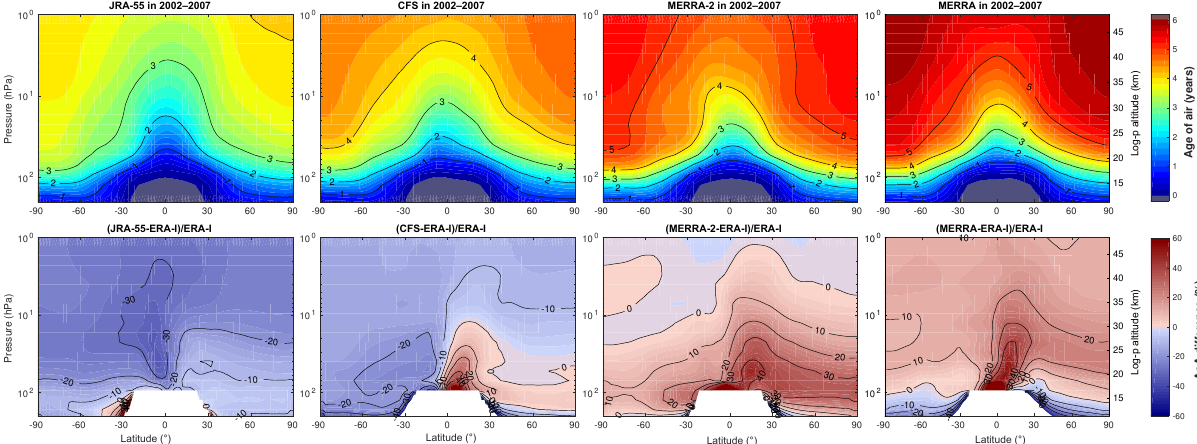
Figure 3. Latitude–pressure distribution of AoA (years) in 2002–2007 from BASCOE simulations driven by all reanalyses but ERA-I (top row; same color scale as previous figure) and relative difference with respect to the mean AoA by the ERA-I-driven simulation for the same period (bottom row; difference is not plotted at grid points where ERA-I AoA is smaller than 5 days). These reanalyses are, from left to right, JRA-55, CFSR, MERRA-2 and